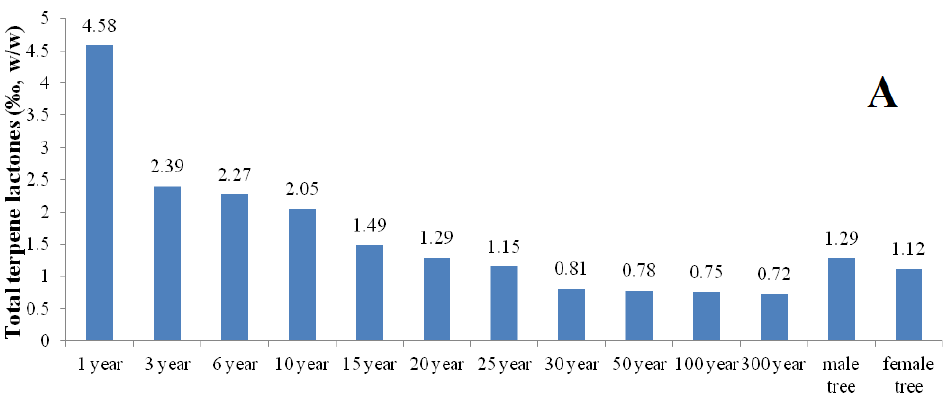
Figure 3. Comparison of the total terpene lactones in the G. biloba leaves collected from different ages (A), cultivation sources (B) and genders